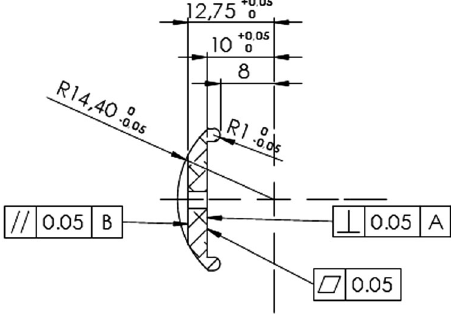
FIG. 14. Fabrication tolerances for the electrodes.